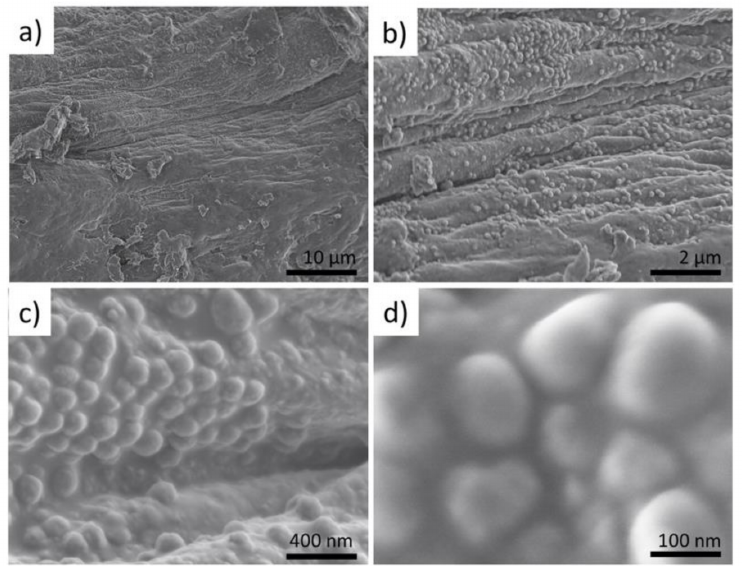
Figure 3. SEM images of the selected fragment treated with a distilled fragment of I. basta sponge skeletal fiber ( a ) show the presence of sphere-like nanoparticles ( b – d